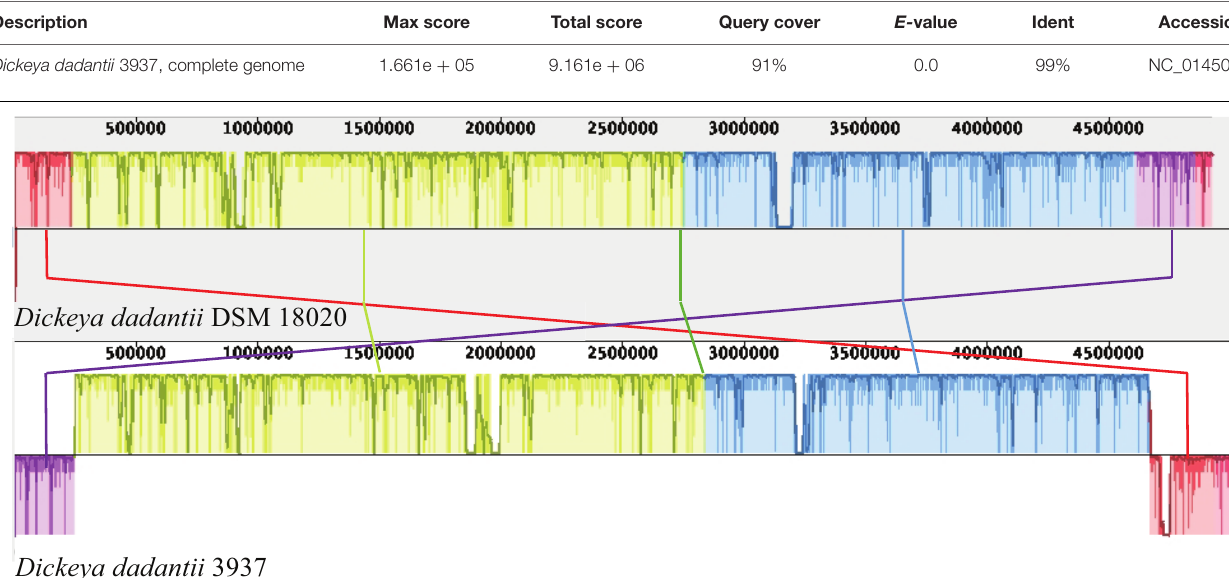
TABLE 2 | Direct comparison of Dickeya dadantii DSM 18020 and 3937 complete genomes. Description